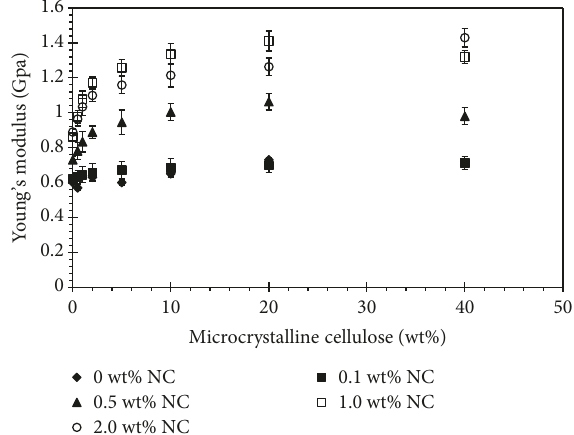
Figure 14: Young’s modulus of PP/MCC composites as a function of NC wt%.